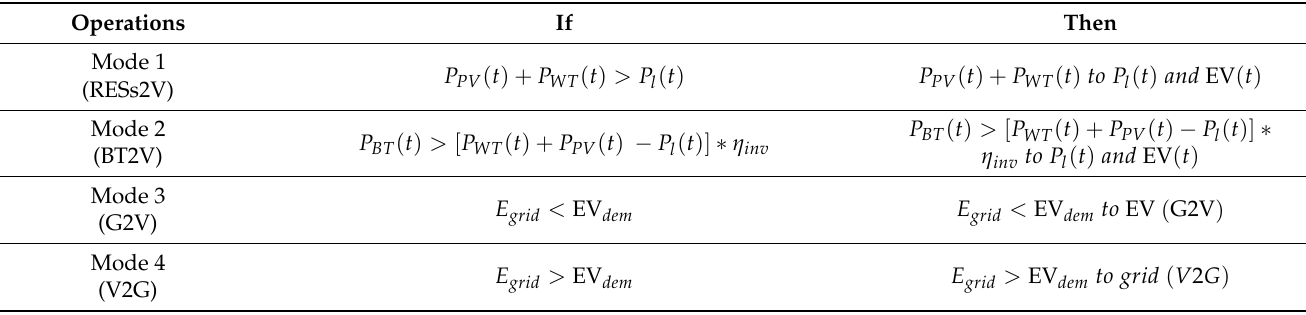
Table 2. The proposed Rule-Based-Energy Management Strategy operation